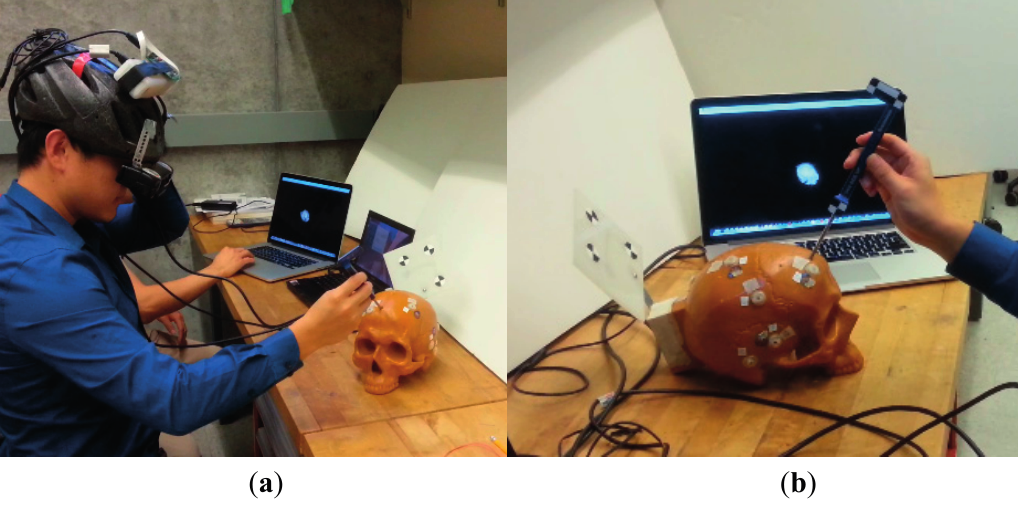
Figure 8. ( a ) Experimental setup; ( b ) Reference marker attached on the surgical target and tool marker attached on the surgical